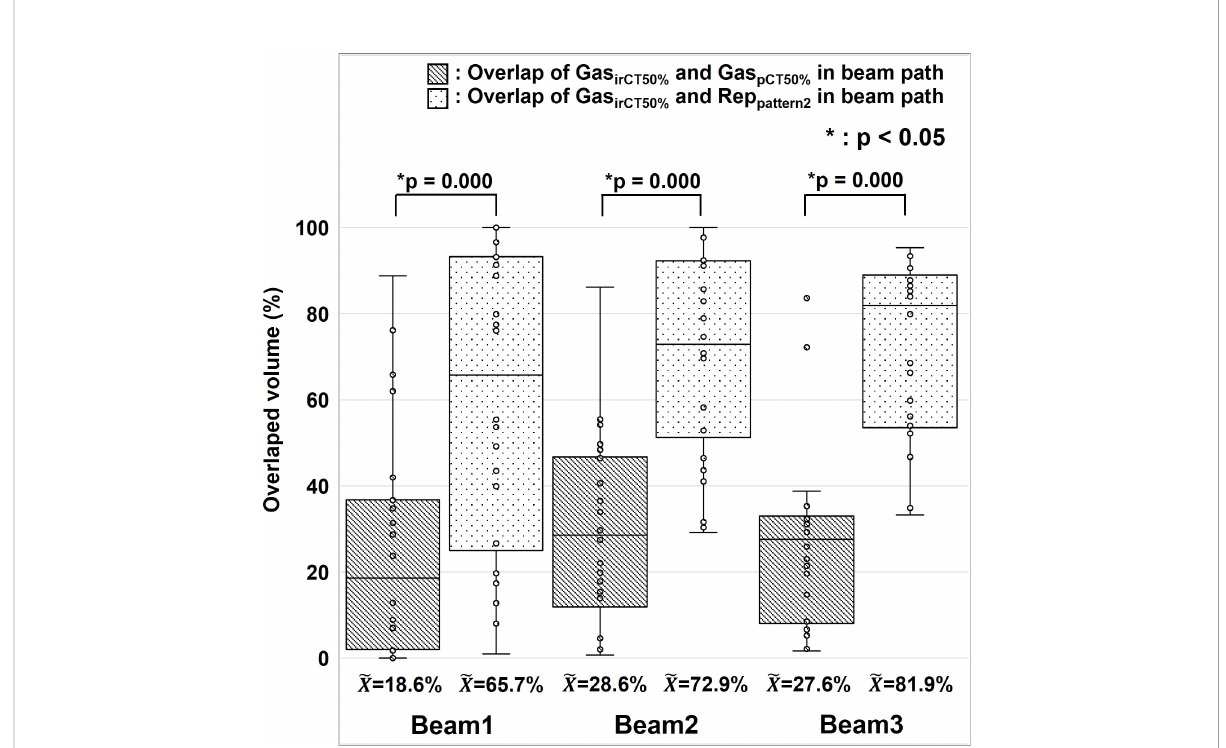
FIGURE 6 Positional changes of gastrointestinal gas. The median, fi rst and third quartile, maximum and minimum values, and outliers for the concordance of gas contouring is presented in a box-and-whisker plot per each beam. The gas contour of the treatment planning CT images is presented as Gas pCT50% , the gas contour in the in-room CT images is presented as Gas irCT50% , and the replacement region set using Pattern 2 during treatment planning is presented as Rep pattern2 . We used the Wilcoxon signed rank test for the statistical analysis. The symbol * indicate that there is a signi fi cant difference between